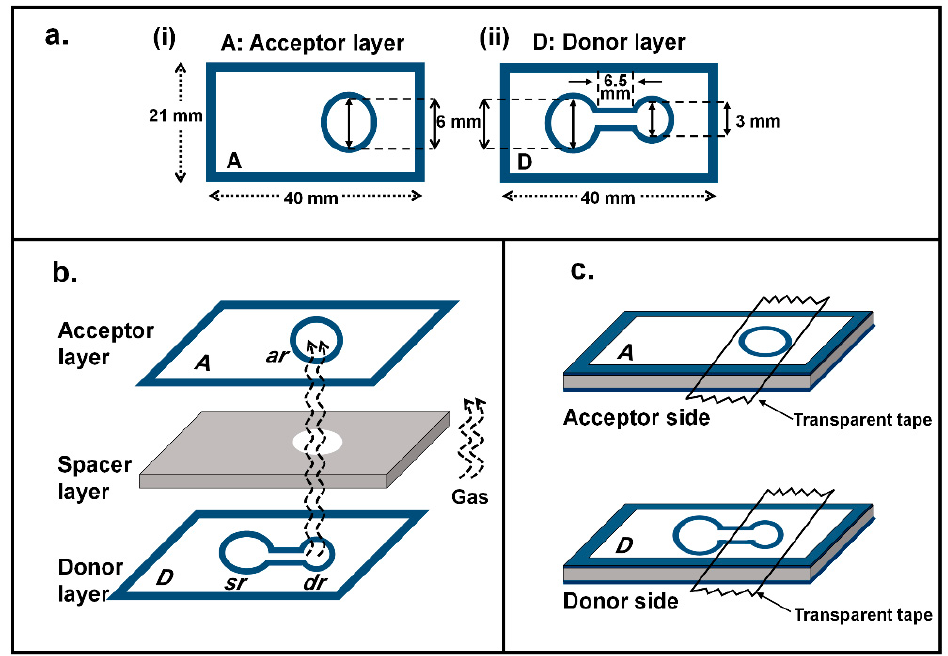
Figure 1. ( a ) The µ PAD pattern: (i) acceptor layer A with circular-shaped barrier and (ii) donor layer D with dumbbell-shaped barrier. ( b ) The three layers of the membraneless gas-separation µ PAD, showing alignment of the donor layer, the spacer layer with circular hole and the acceptor layer. ( c ) 3D-view of assembled device from both the acceptor and donor sides, with position of the transparent tapes.